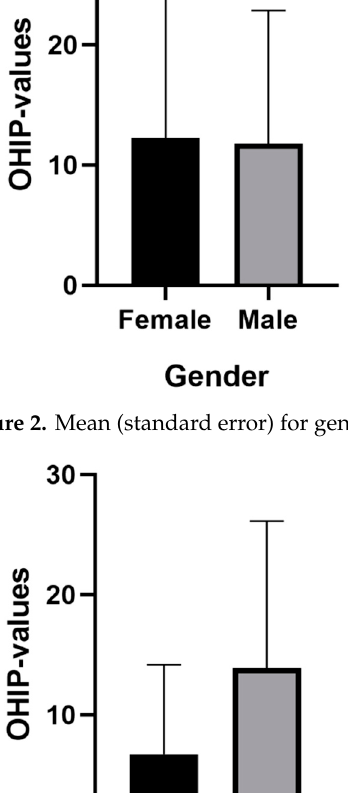
Figure 3. Mean (standard error) for satisfaction with the health system.